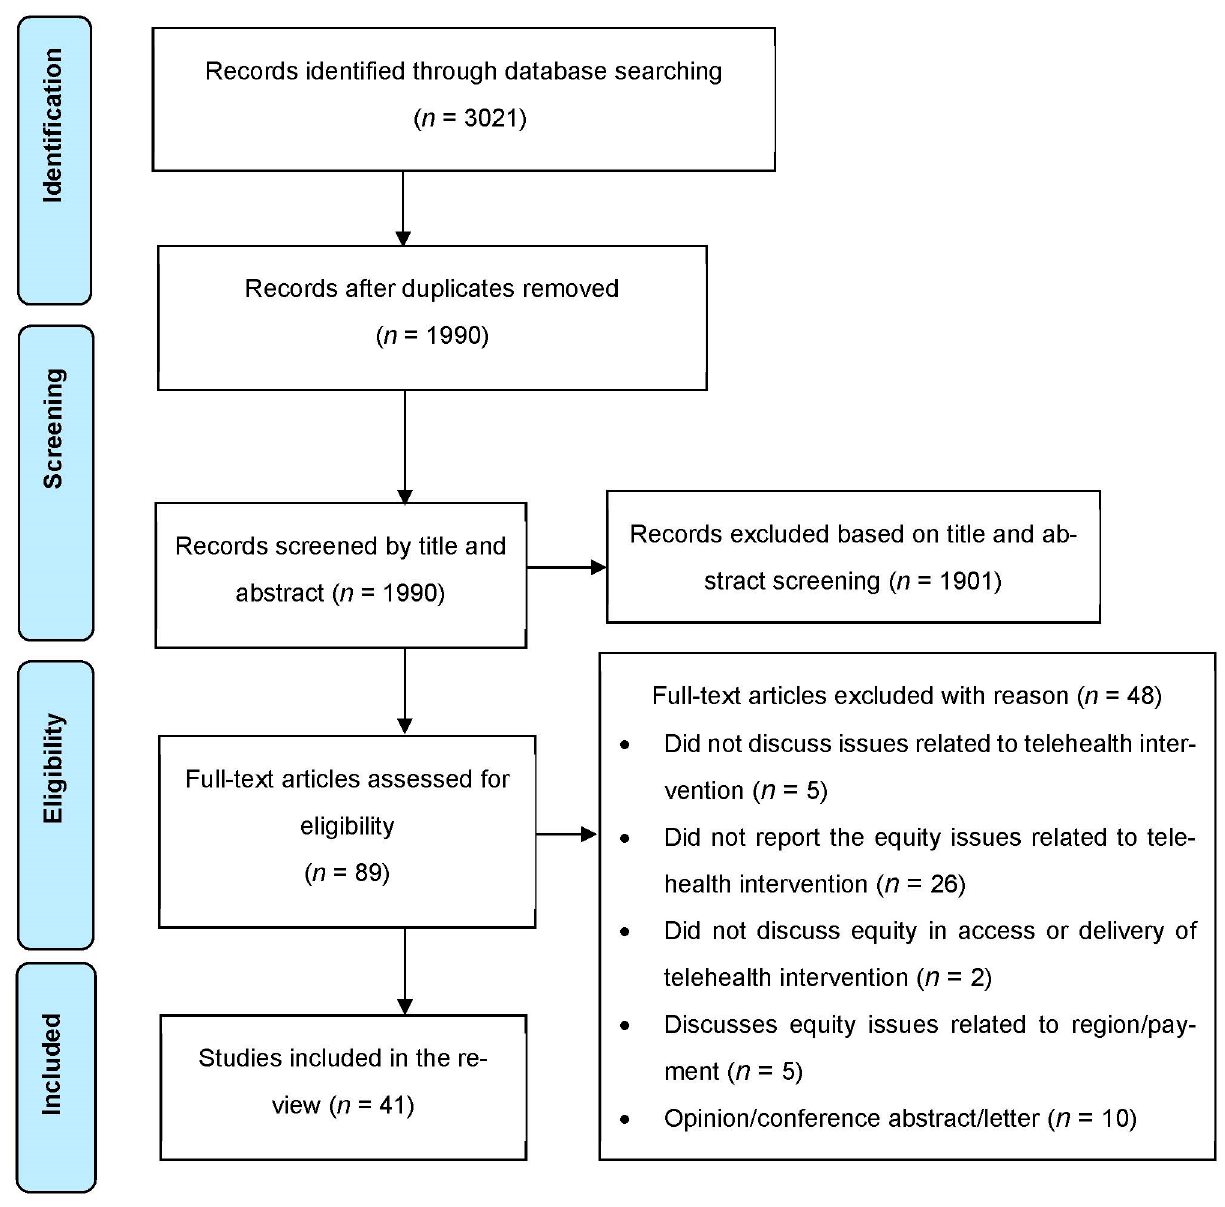
Figure 1. PRISMA diagram of study selection.